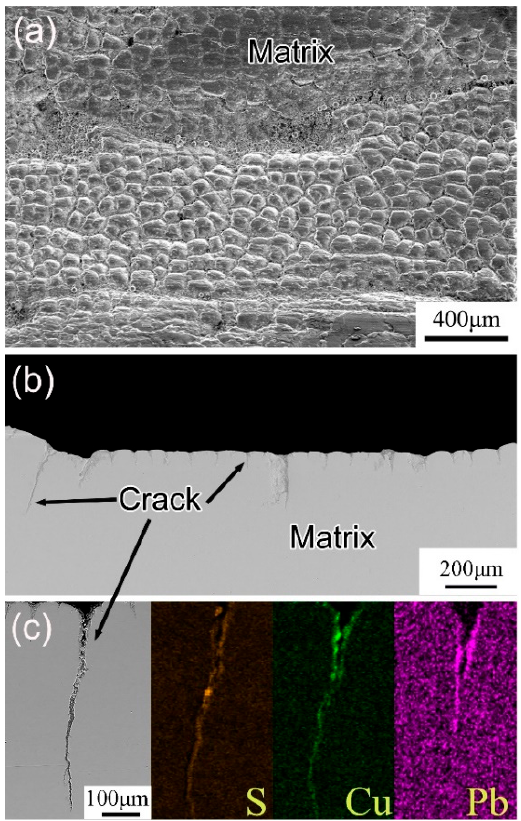
Figure 4. SEM morphologies of MG1: ( a ) bore surface; ( b ) cracks in the cross-section; and ( c ) the EDS energy spectrum of a crack.